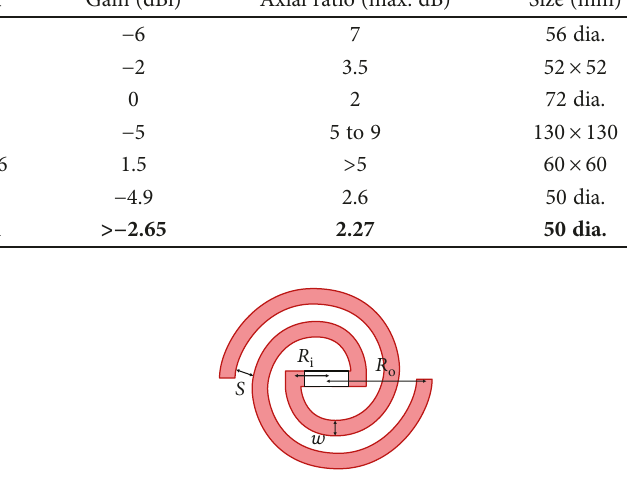
Figure 1: Simple Archimedean spiral antenna in the air.